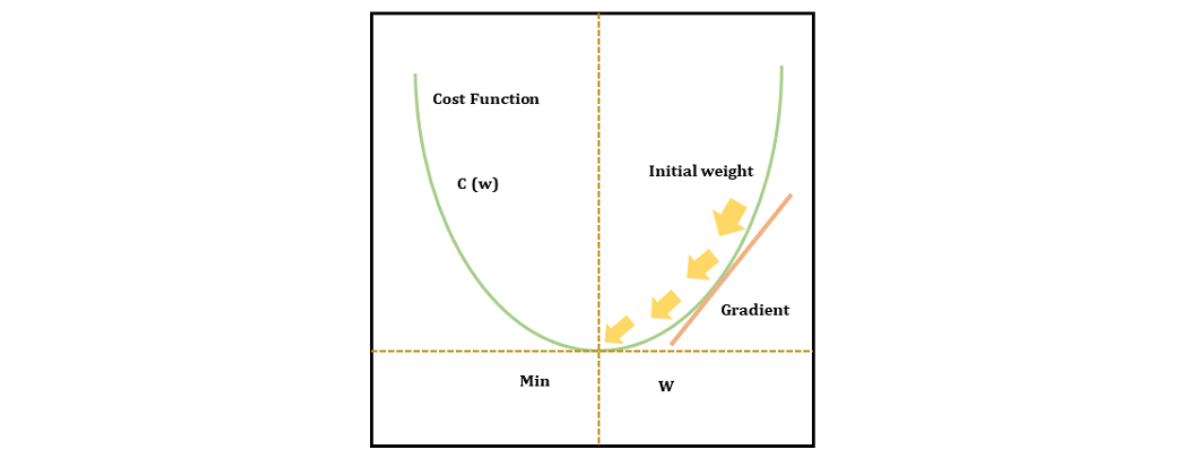
Figure 3. The process of gradient